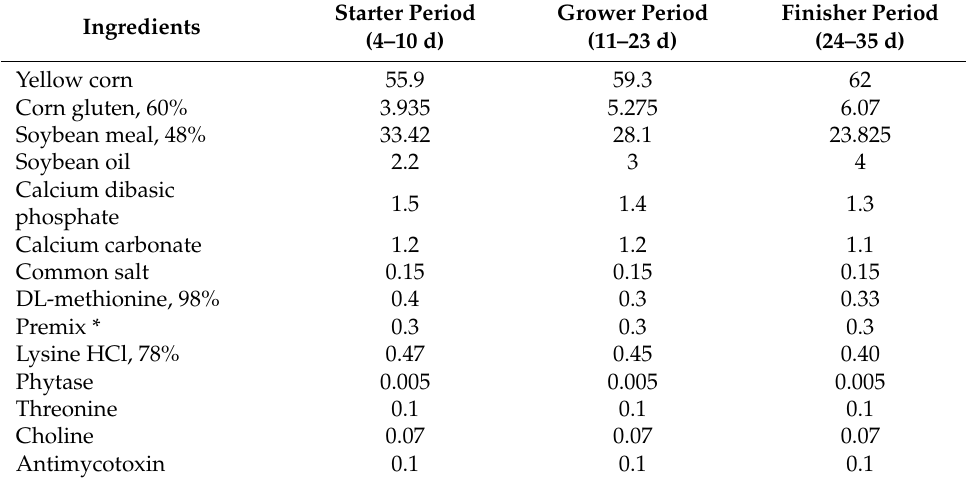
Table 1. Proximate Chemical Composition of the Experimental Diets